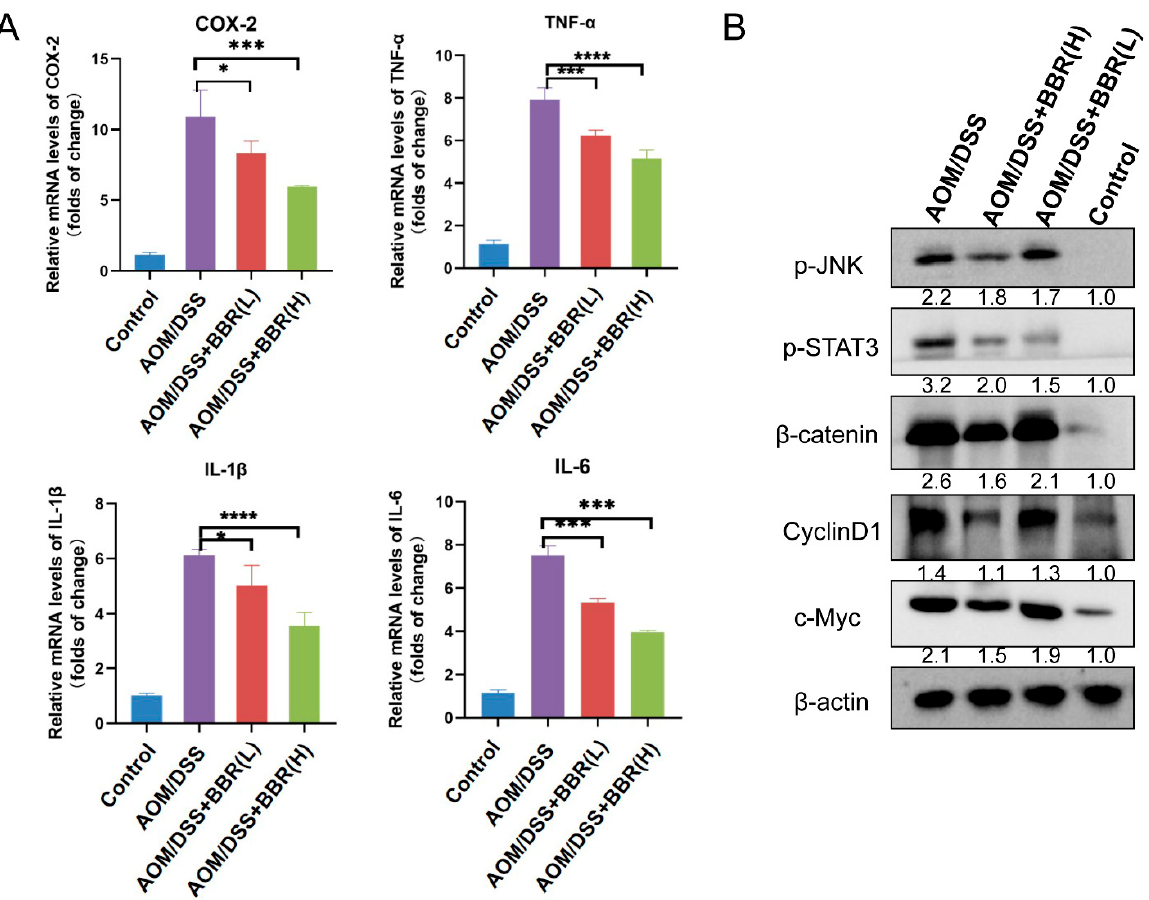
Figure 5. Detection of inflammatory factors in colon tumor tissue. ( A ) The expression levels of inflammatory factors COX-2, TNF- α , IL-1 β and IL-6 in colon tissues detected by RT-qPCR. β -actin was used as internal control to normalize target gene transcription, and relative mRNA expression was calculated by the 2 − ∆∆ Ct method ( n = 5). ( B ) The protein expression of p-JNK, p-STAT3, β - catenin, CylinD1 and c-Myc were examined by Western blot analysis. β -actin was used as the loading control. Relative expression of proteins was quantified using ImageJ and expressed as a ratio. Data are presented as mean ± SEM of the indicated number of independent experiments. “*” p < 0.05, “***” p <0.001, “****” p < 0.0001 vs. model group (AOM/DSS